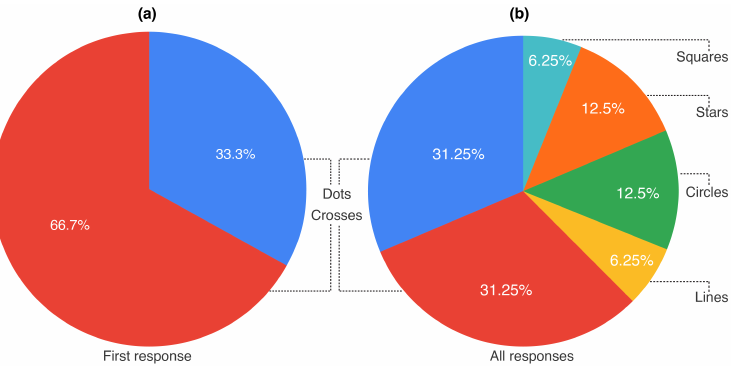
Figure 4. ( a ) Result of the first response to the question: What gesture would you most likely make with a stylus to instruct the system of the exact location of the paper on a tablet screen? ( b ) Aggregated results for all three